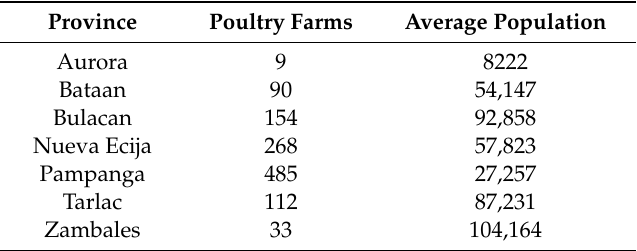
Table 1. Distribution of poultry farms in the provinces of Central